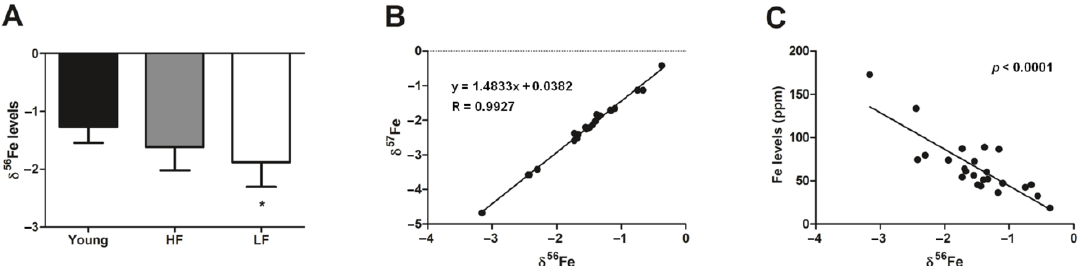
Figure 2 . Iron isotope data for the vastus lateralis muscle of young and old participants. ( A ) Comparison by one-way ANOVA of δ 56 Fe among young participants ( n = 11) and high- (HF, n = 16) and low-functioning (LF, n = 7) older adults. ( B ) Linear regression analysis between δ 57 Fe and δ 56 Fe in young and old participants. ( C ) Relationship between total Fe levels and δ 56 Fe in young and old participants as assessed by Pearson’s test. In ( A ) bars represent mean values ( ± standard deviation) for the three experimental groups. Values are expressed as ppm Fe. * p < 0.05 vs. young group.